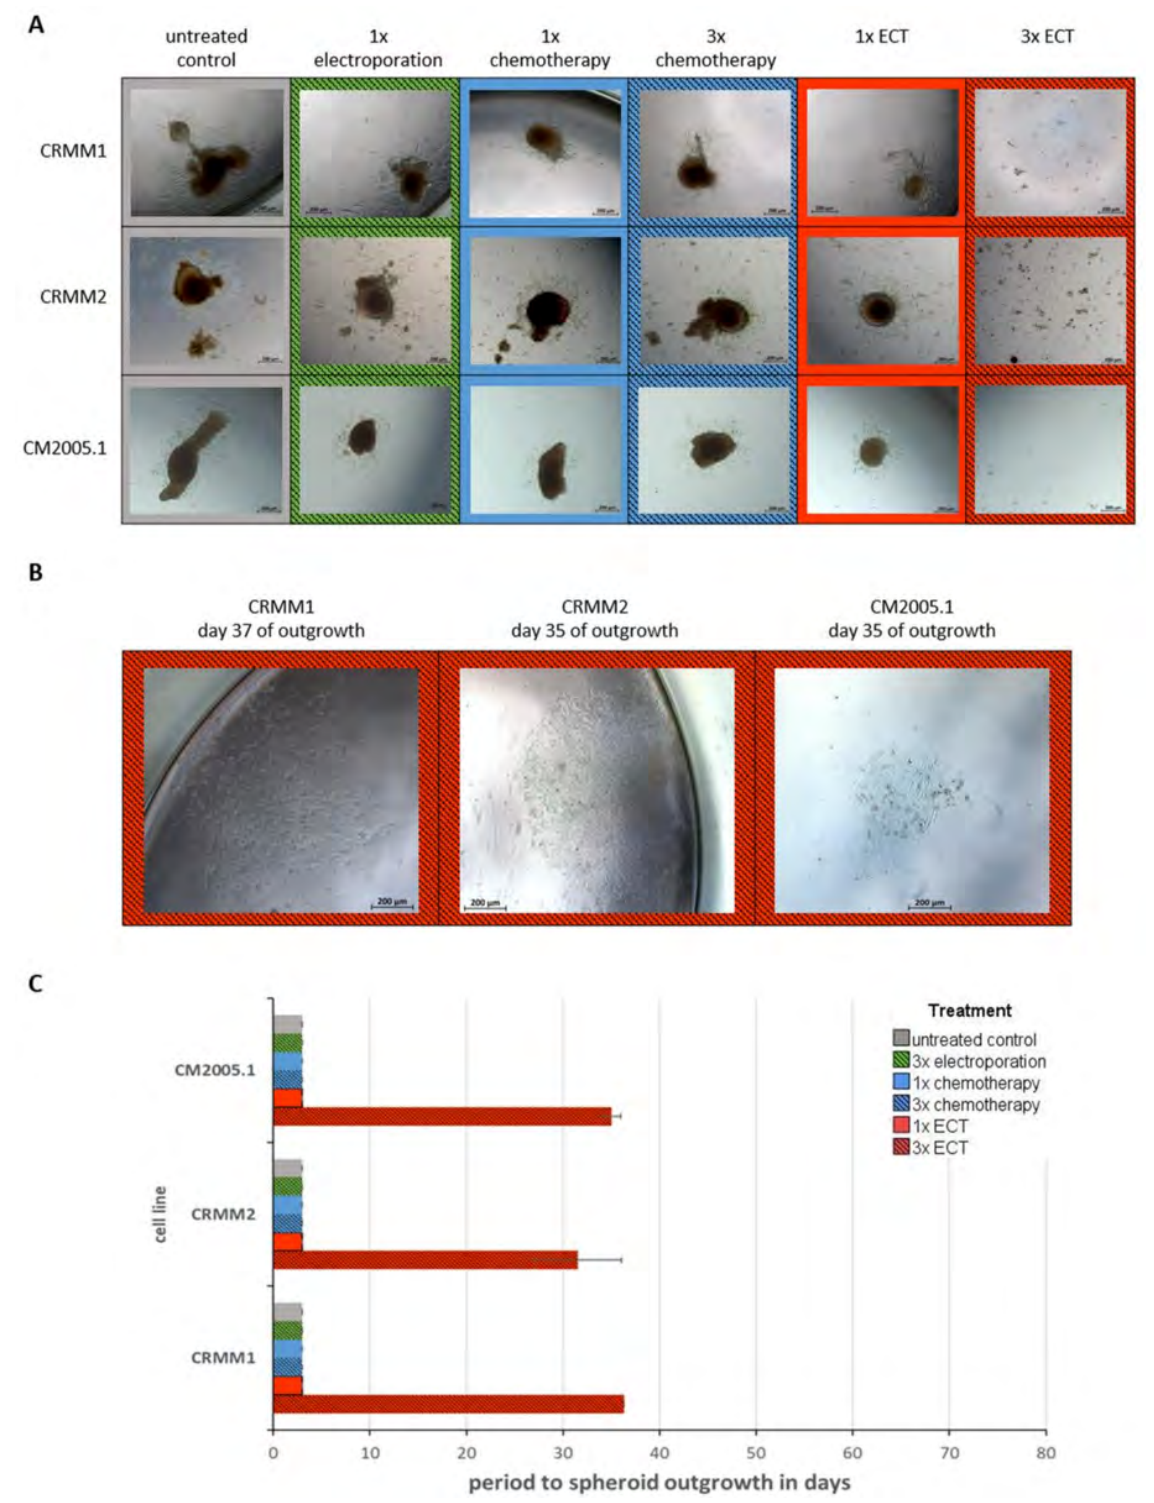
Figure 6. Comparison of the outgrowth capacity of 3D spheroids from the conjunctival melanoma cell lines CRMM1, CRMM2, CM2005.1 after different treatments by recultivation in cell culture plates. ( A ) Representative microscopic images of 3D spheroids on day 3 of outgrowth; ( B ) Representative mi- croscopic images of proliferating cell colonies from 3 × ECT-treated spheroids after recultivation in cell culture plates; ( C ) Comparison of the median time to outgrowth of spheroids from conjunctival cells treated with different applications. Scale bar = 200 µ m. Abbreviations: ECT =